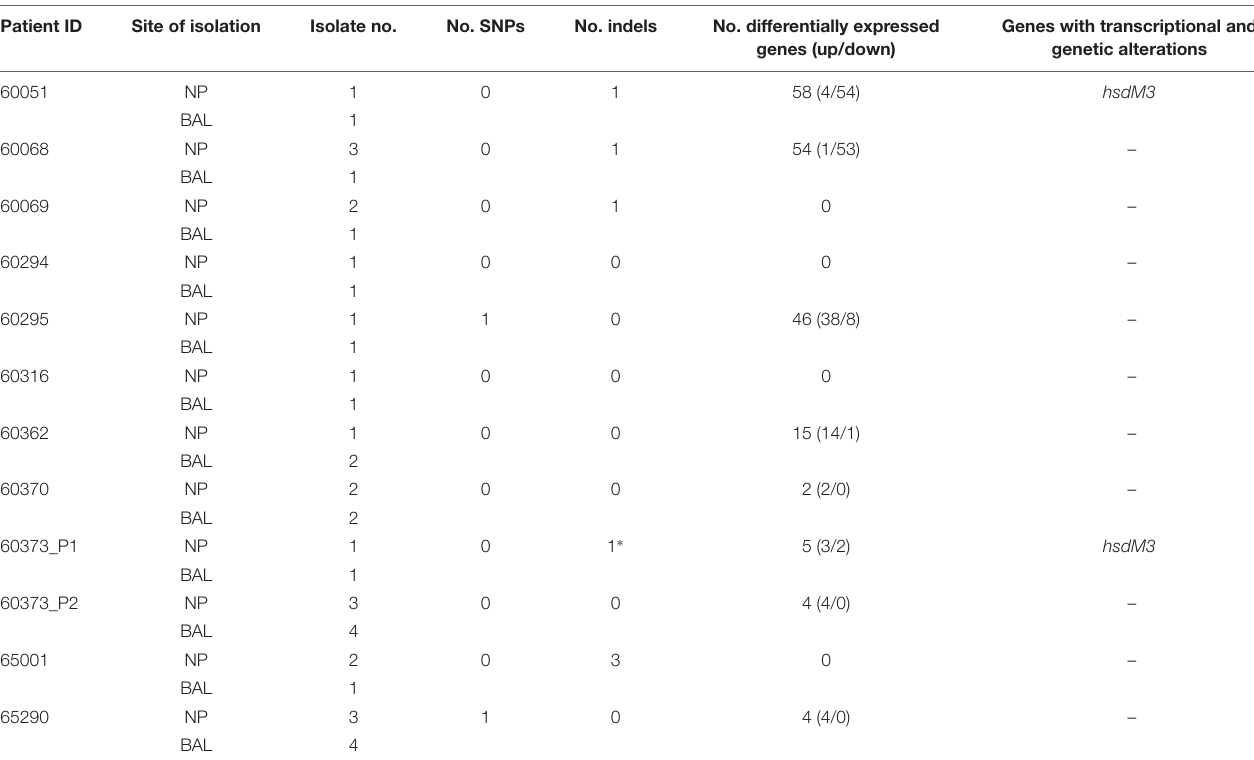
TABLE 1 | Summary of genomic and transcriptomic differences between paired, isogenic NTHi isolates obtained from the nasopharynx (NP) and lower airways (bronchoalveolar lavage; BAL) of 11 Australian children with chronic lung disease. Patient ID Site of isolation Isolate no. No. SNPs No. indels No. differentially expressed